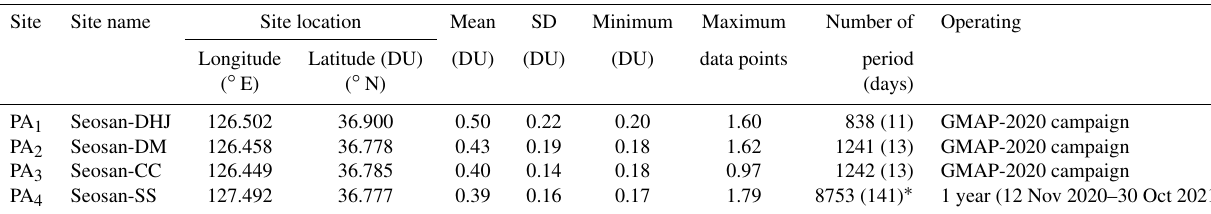
Table 1. Summary of NO 2 column data from four Pandora (PA) measurement sites.